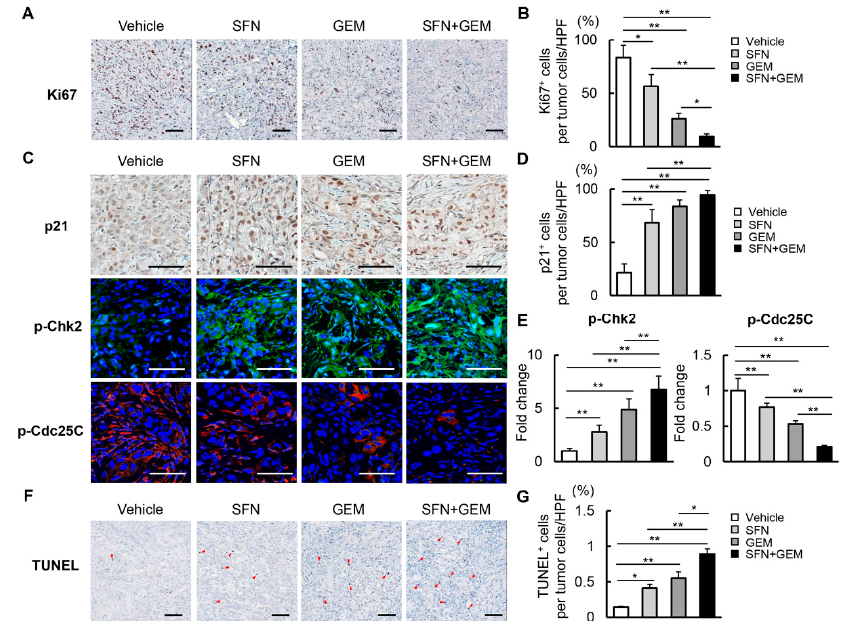
Figure 6. Cell proliferation and apoptosis in iCCA-derived xenograft tumors by treatment with SFN and GEM. ( A , C , F ) Representative images of HuCCT-1-grafted tumors stained with Ki67 ( A ), p21, p-Chk2, and p-Cdc25C ( C ), TUNEL ( F ). Red triangles indicate intratumor apoptotic cells. Scale bar; 100 μ m. ( B ) Quantification of Ki67 + proliferative cancer cells. The values are indicated as Ki67 + can- cer cells/total cancer cells (%) in high power field (HPF). ( D ) Quantification of p21 + cancer cells. Quantitative values are indicated as p21 + cancer cells/total cancer cells (%) in HPF. ( E ) Semi-quanti- tation of p-Chk2 + or p-CdC25C + cancer cells in HPF. The values are shown as fold changes relative to the vehicle-treated group. ( G ) Quantification of TUNEL + apoptotic cancer cells. The values are indicated as TUNEL + cancer cells/total cancer cells (%) in HPF. Each quantitative analysis was per- formed for 10 fields per section. Data are mean ± SD ( n = 20 tumors/10 mice; B , D , E , G ). * p < 0.05, ** p < 0.01, indicating a significant difference between groups.